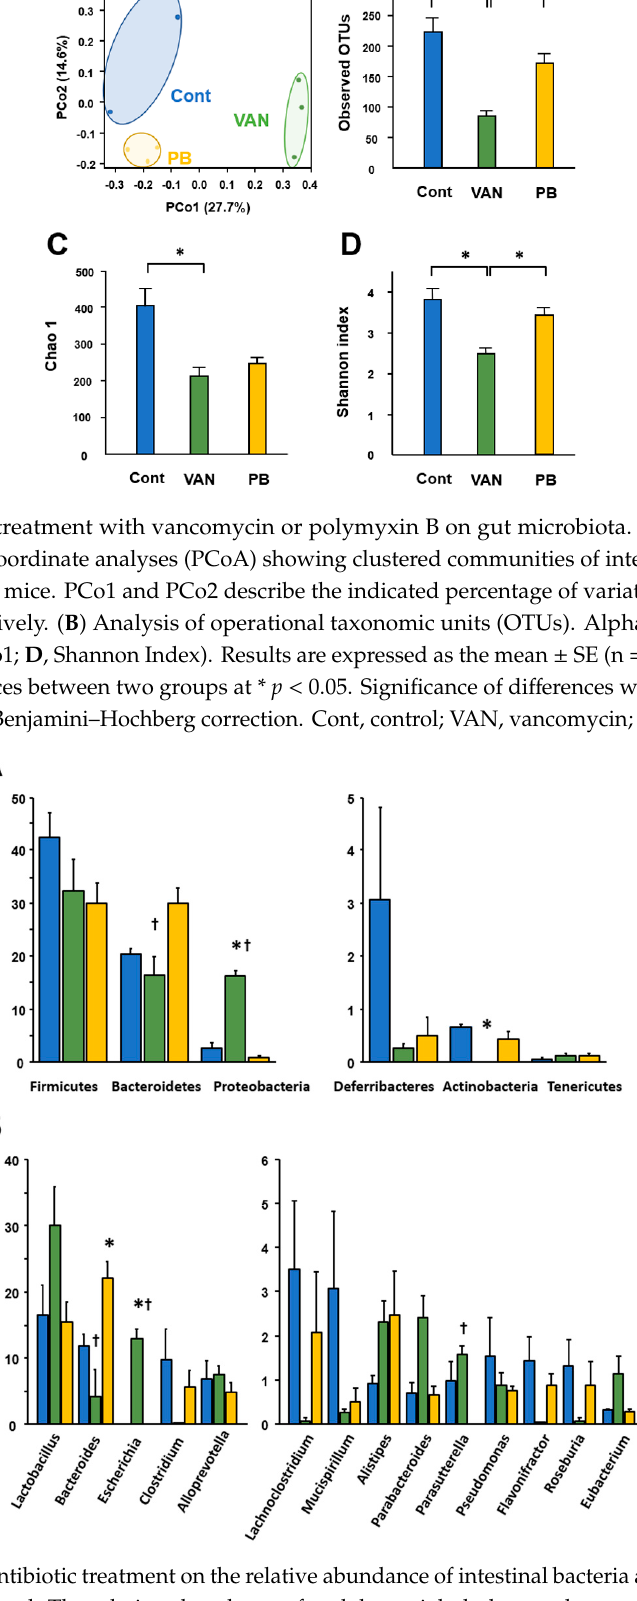
Figure 2. Effect of antibiotic treatment on the relative abundance of intestinal bacteria at ( A ) the phylum and ( B ) the genus level. The relative abundance of each bacterial phylum and genus was analyzed by next-generation sequencing of bacterial 16S rDNA. Cont, control (blue); VAN, vancomycin (green); PB, polymyxin B (yellow). Results are expressed as the mean ± SE (n = 3 in each group). Significant differences between the control and antibiotic-treated groups at * p < 0.05 or between the vancomycin- and polymyxin B-treated groups at † p < 0.05. Statistical significance